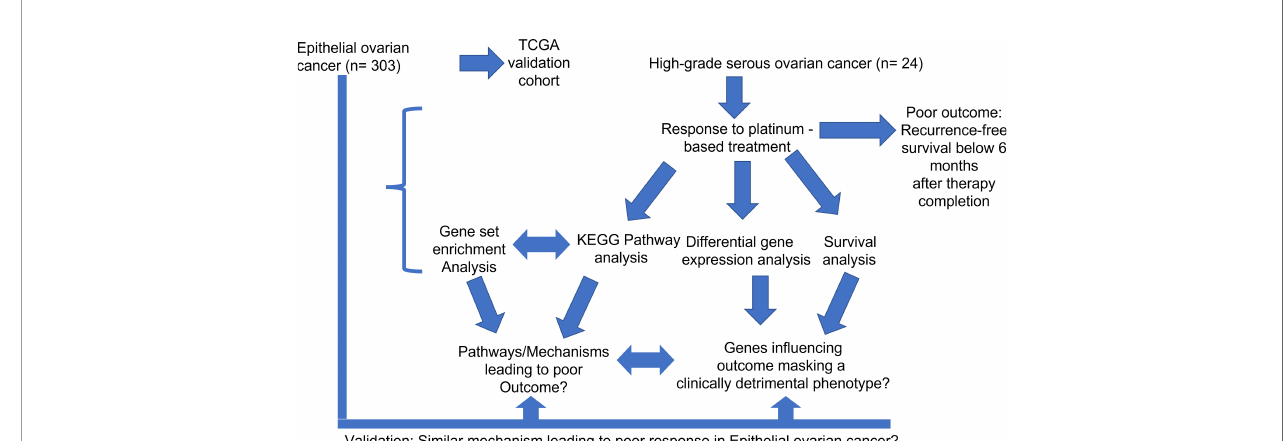
FIGURE 1 | General methodical work fl ow of the